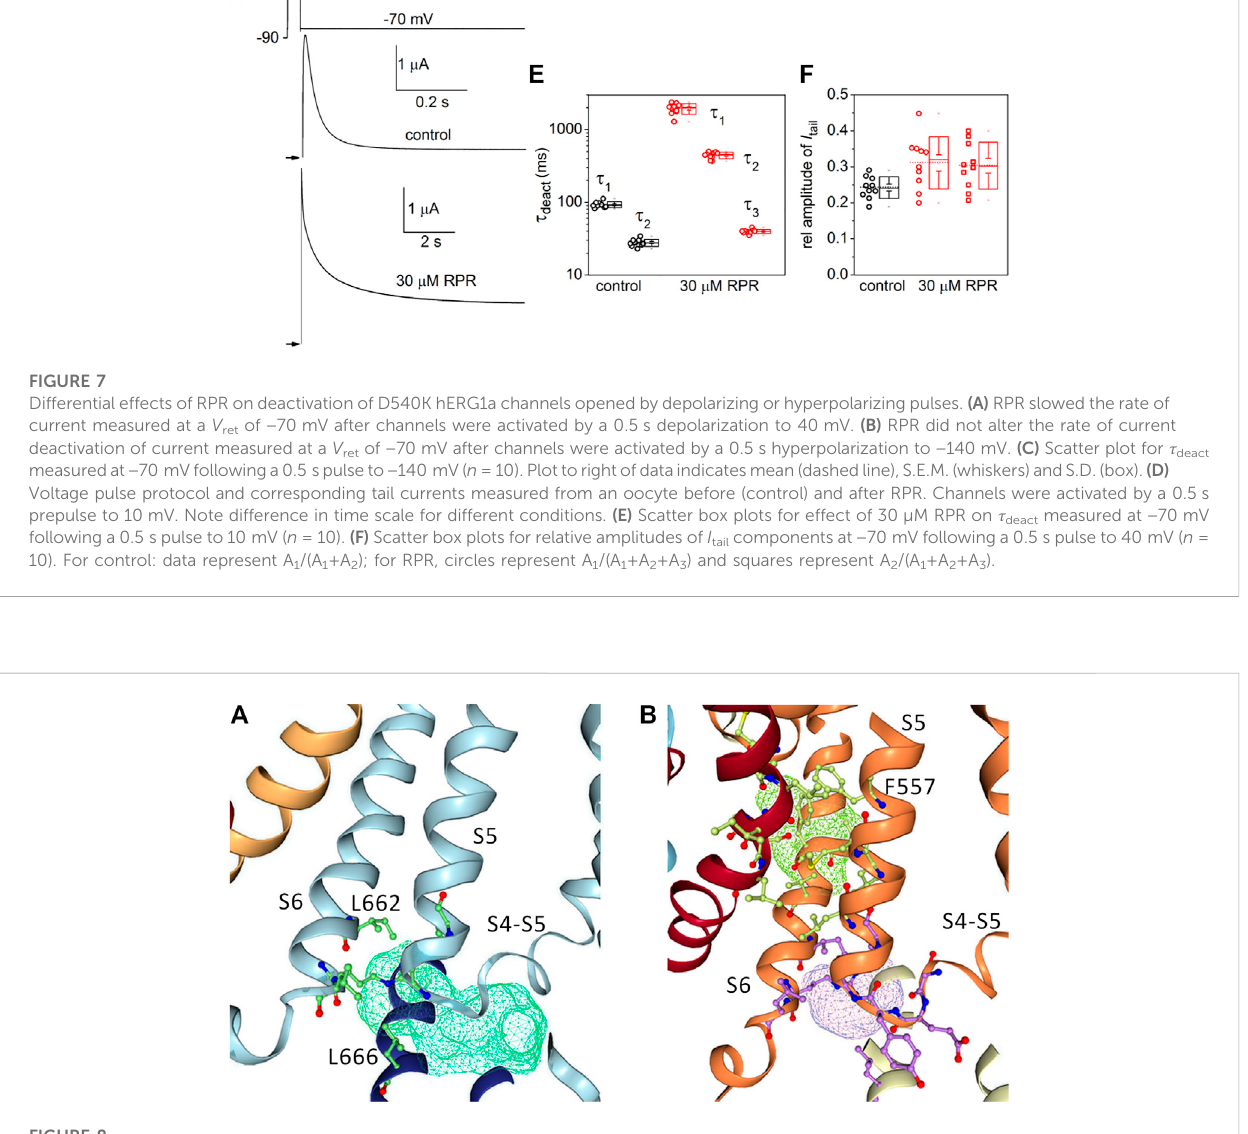
FIGURE 8 PocketanalysisoftheRPRbindingsiteinEAG1andthehERG1channel. (A) PocketanalysisinthehERG1cryoEMstructure(pdb:5VA1).Showninblue aretheS4-S5linker,theS5aswellastheS6helices.Pocket-restrictingresiduesarerepresentedingreen.Thelightbluemeshindicatedthepocketfound by the program DoGSiteScorer. (B) Pocket analysis of a MD snapshot of the hERG1 channel. Shown in orange are the S4-S5 linker, the S5 as well as the S6 helices. The light purple mesh indicated the pocket found by the program DoGSiteScorer. Pocket-lining residues are represented in green and